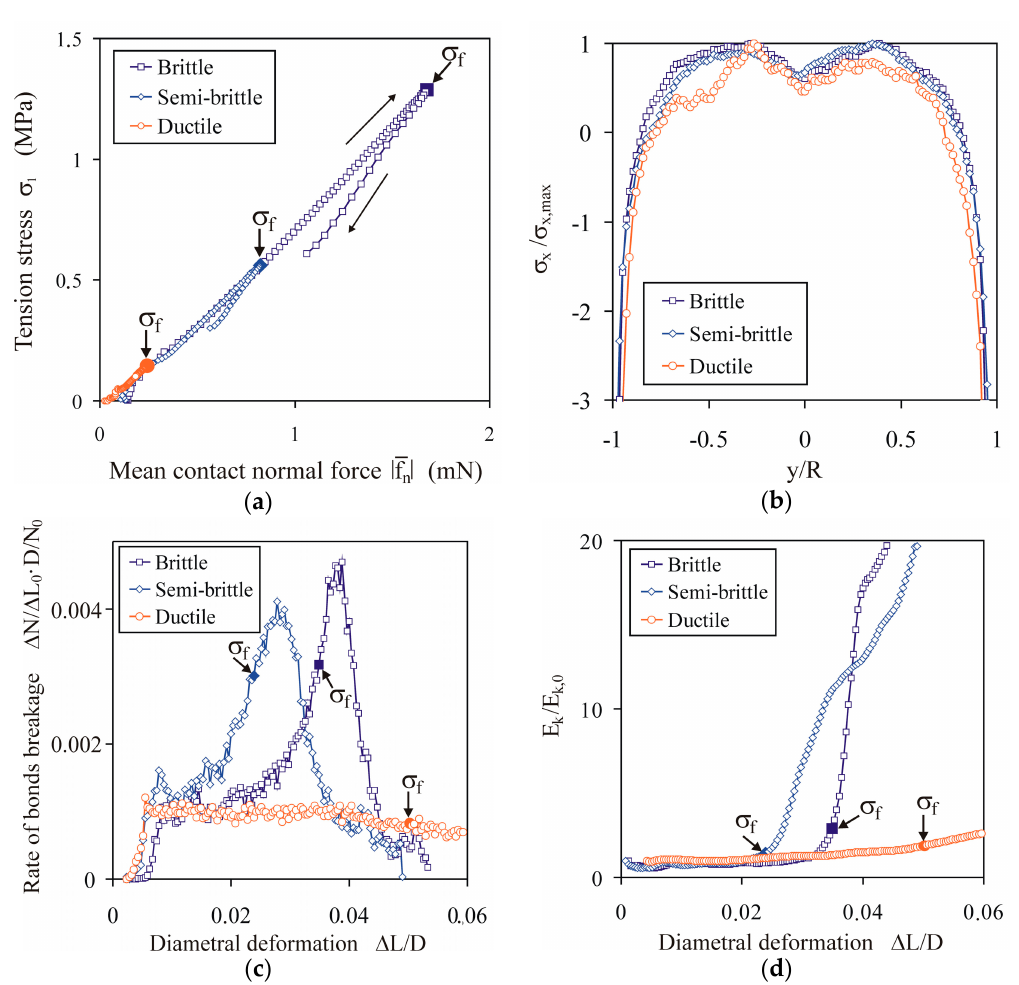
Figure 11. Relationships between micro- and macro-variables for brittle ( σ c = 18 MPa, E b = 400 MPa), semi-brittle ( σ c = 7.5 MPa, E b = 200 MPa), and ductile ( σ c = 10 MPa, E b = 25 MPa) breakage modes: ( a ) dependence of σ 1 on the mean value of the magnitude of the contact normal force (cid:12) f n (cid:12) ; ( b ) profiles of the normalized averaged stress component σ x / σ x, max along the y direction; ( c ) the normalized rate of bond breakages ∆ N / ∆ L 0 · D / N 0 vs. diametral deformation, where ∆ N is the number of bonds broken during the diametral deformation increment ∆ L 0 / D of 3.92 × 10 − 5 , and N 0 is the initial number of bonds; ( d ) normalized kinetic energy of particles E k / E k, 0 vs. diametral deformation.